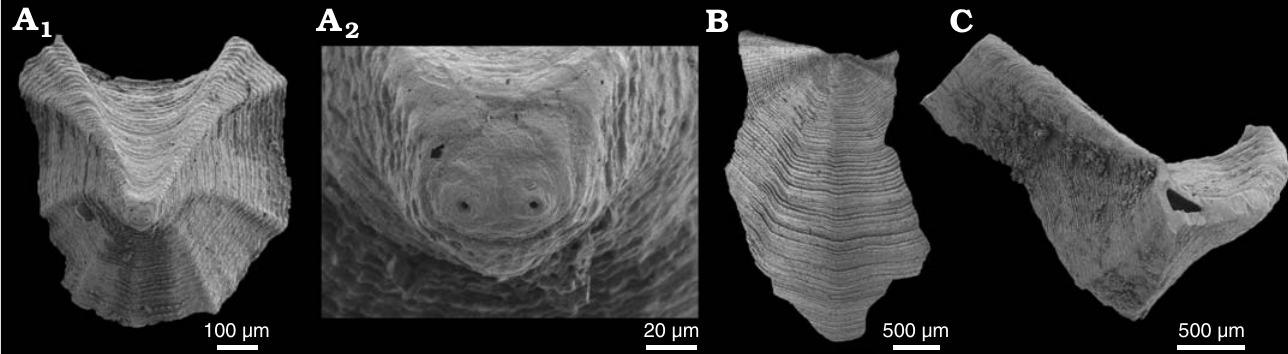
Fig. 14. The camenellan tommotiid Dailyatia odyssei Evans and Rowell, 1990 from the lower Cambrian White Point Conglomerate, Kangaroo Island, South Australia. A . SAM P57326, A2 sclerite in apical view (A 1 ); A 2 , detail of the double perforations in the apex. B . SAM P57327, A2 sclerite in apical view, tilted to show deltoid. C . SAM P57328, C2 sclerite in dorsal